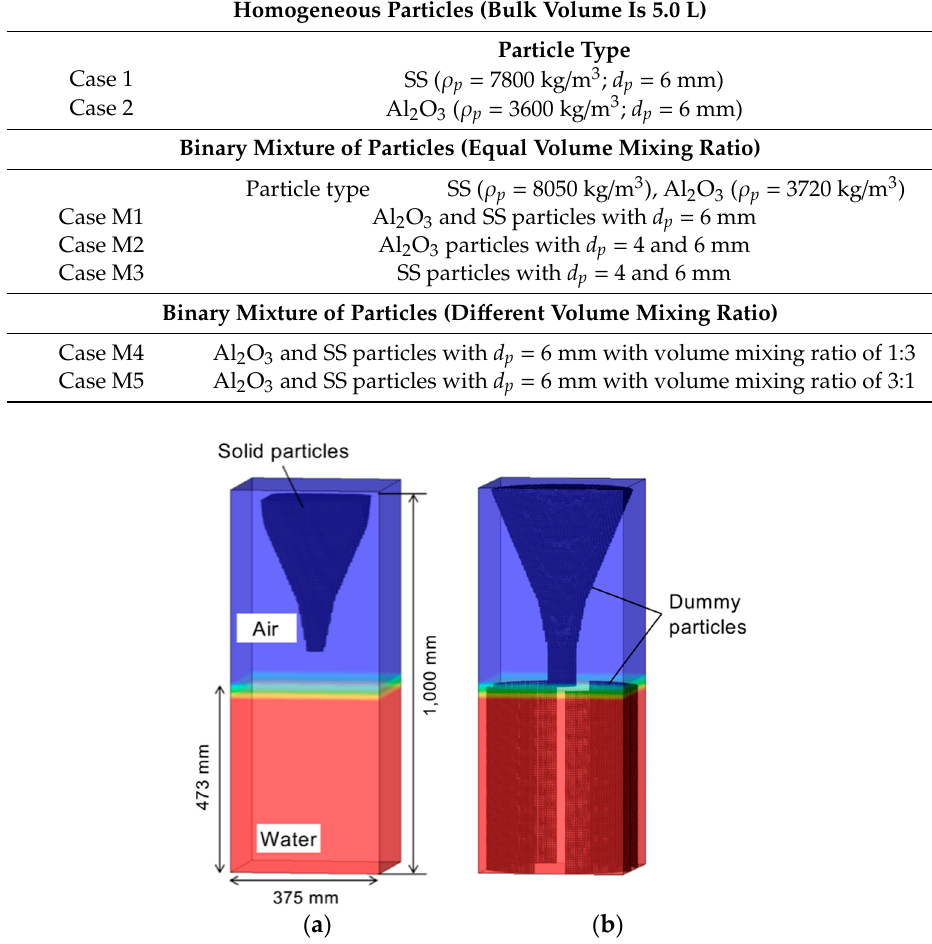
Figure 2. Schematic illustration of the setups for the simulation (color bar: volume fraction of water phase): ( a ) initial arrangement of solid particles; ( b ) arrangement of dummy particles.